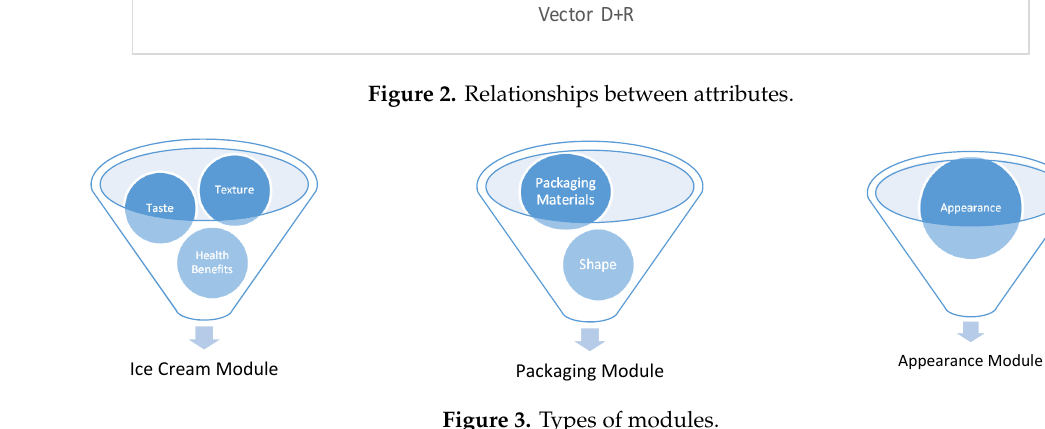
Figure 2. Relationships between attributes.